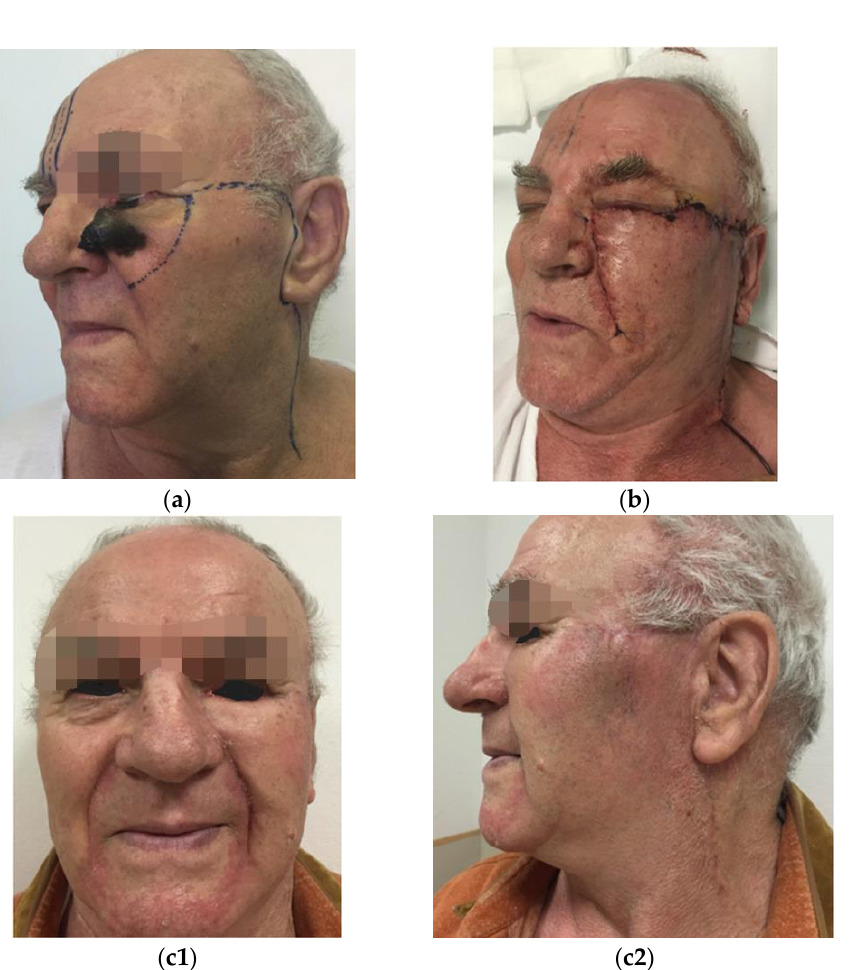
Figure 1. ( a ) Locally advanced NMM of the cheek preoperatively; ( b ) two-week follow up; ( c ) six- month follow-up.